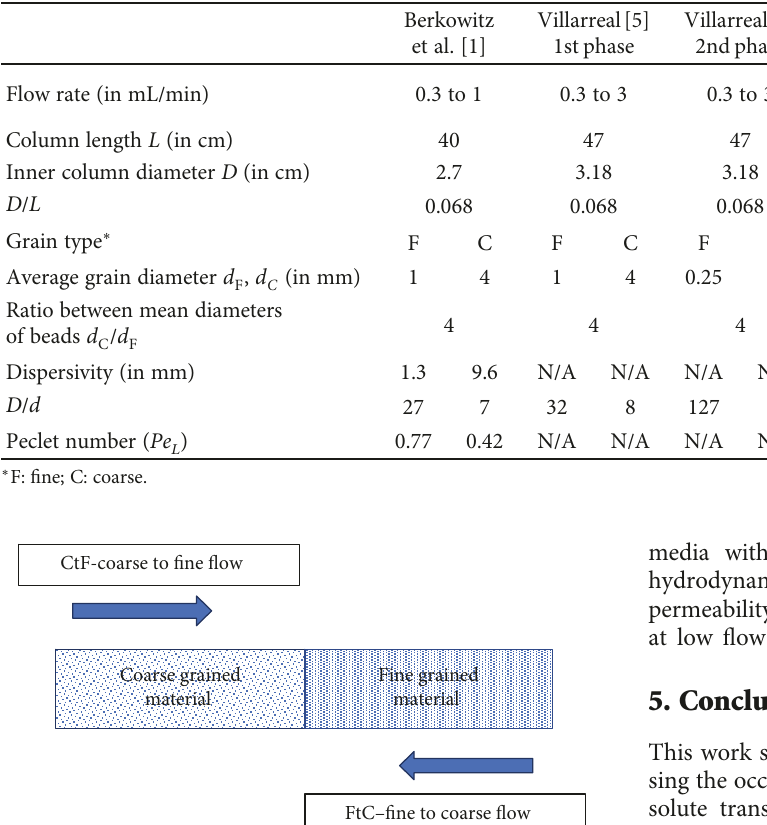
Table 4: Characteristics of the glass beads used for the experiments in two-layer media.